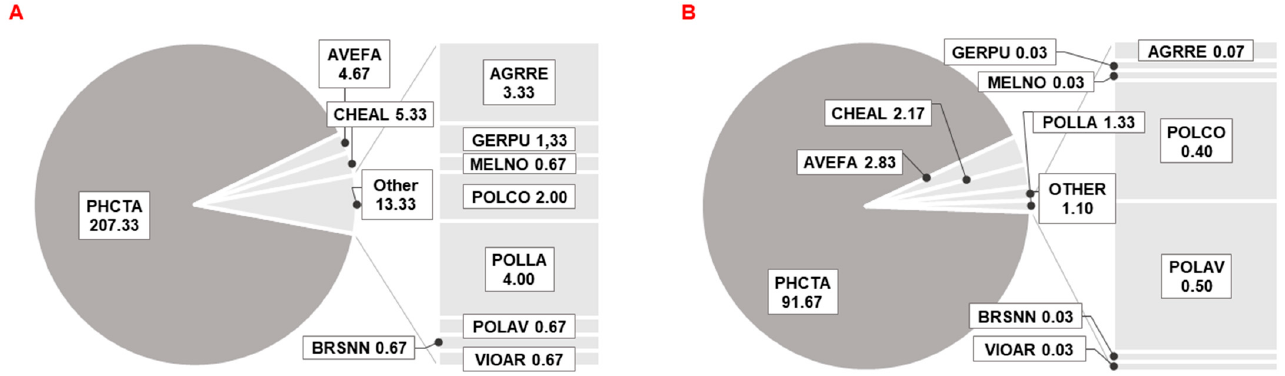
Figure A5. Number of plants per m 2 —Sowing 2 (16th of April) in 2019 ( A ) and leaf coverage in %— Sowing 2 (16th of April) in 2019 ( B ). Figure A6. Number of plants per m 2 —Sowing 3 (7th of May) in 2019 ( A ) and leaf coverage in %— Sowing 3 (7th of May) in 2019 ( B ).